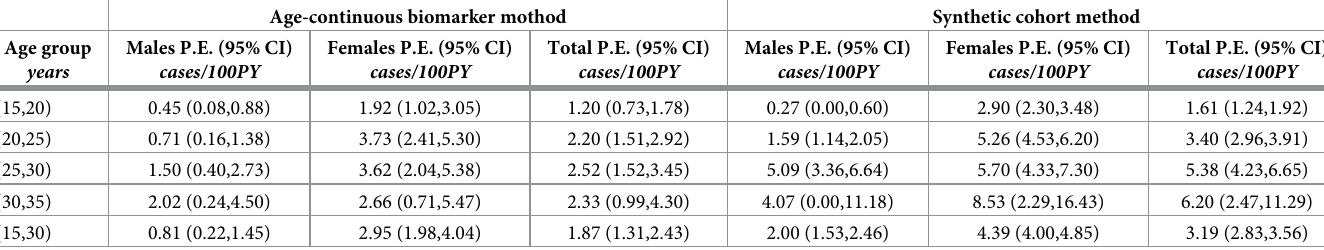
Table 2. ‘Average incidence’ estimates by age group using the biomarker and synthetic cohort methods.